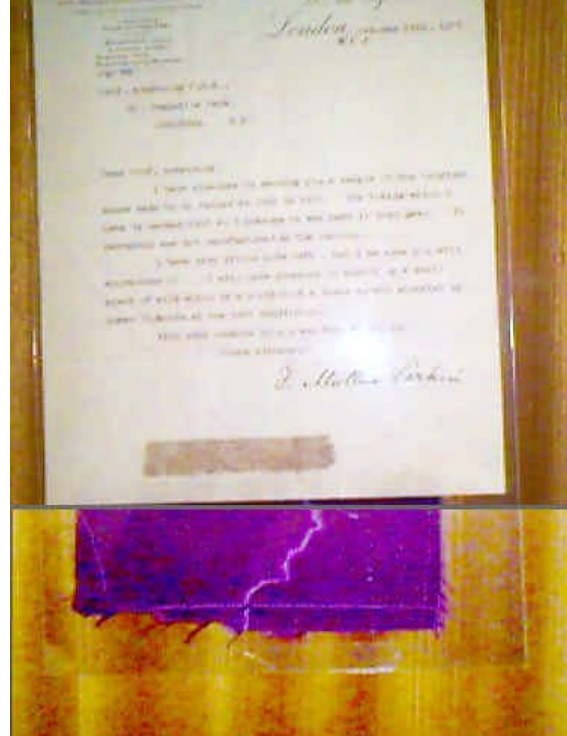
Figure 4. Perkin's mauveine.